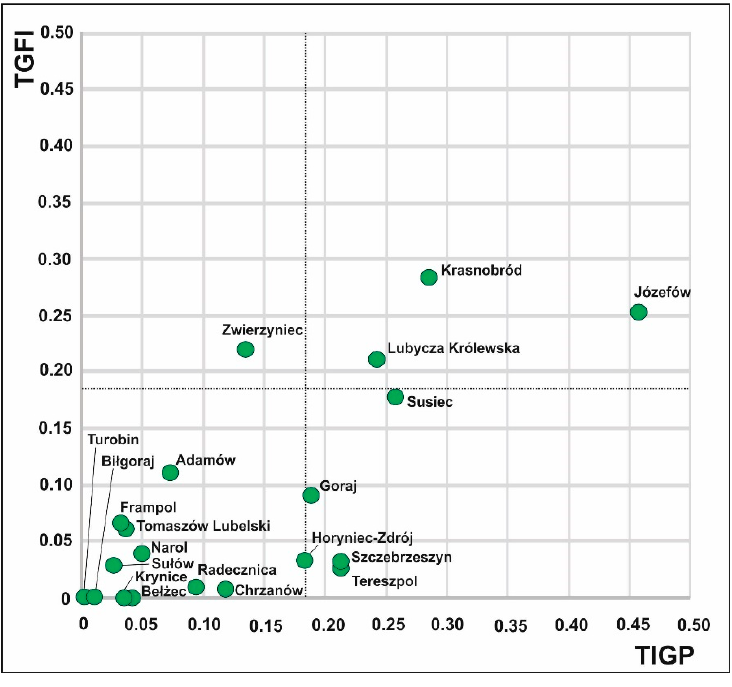
Figure 9. Location of the Roztocze TBR communes in the two-dimensional space of the total indicator of geotourism potential (TIGP) and the total geotourism function index (TGFI).